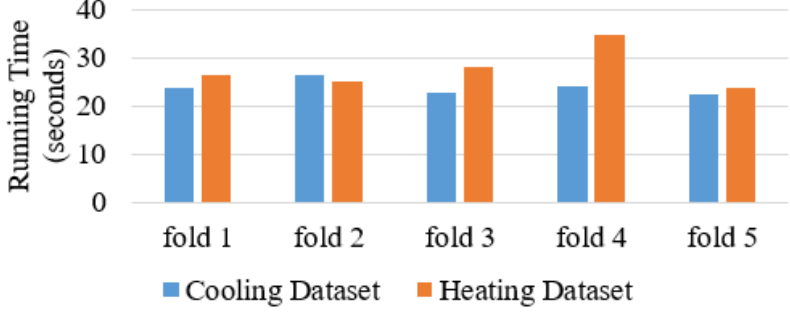
Figure 11. PTA Ensemble Running Time Results Summary.